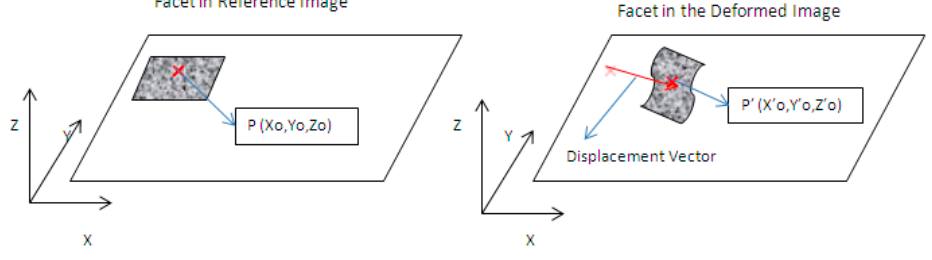
Figure 2. Displacement of a facet from a reference image to a strained image using DIC.